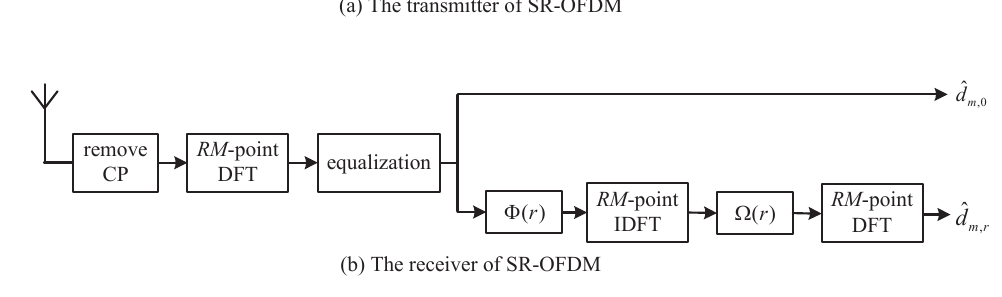
Figure 1. The system diagram of